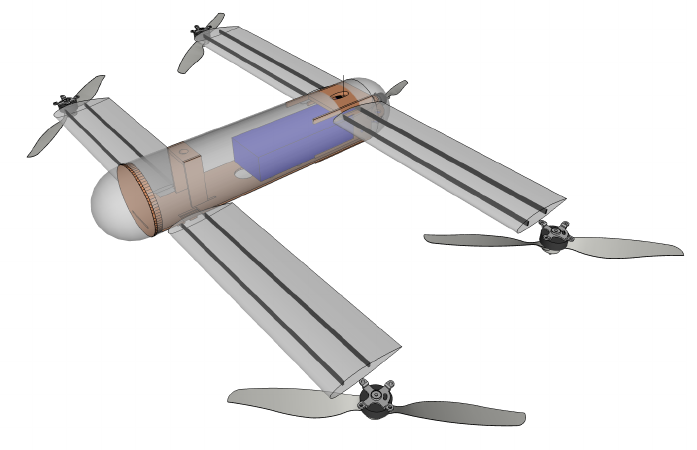
Figure 15. The final design of Elka1Q fuselage—a PVC tube with internal plywood structure.